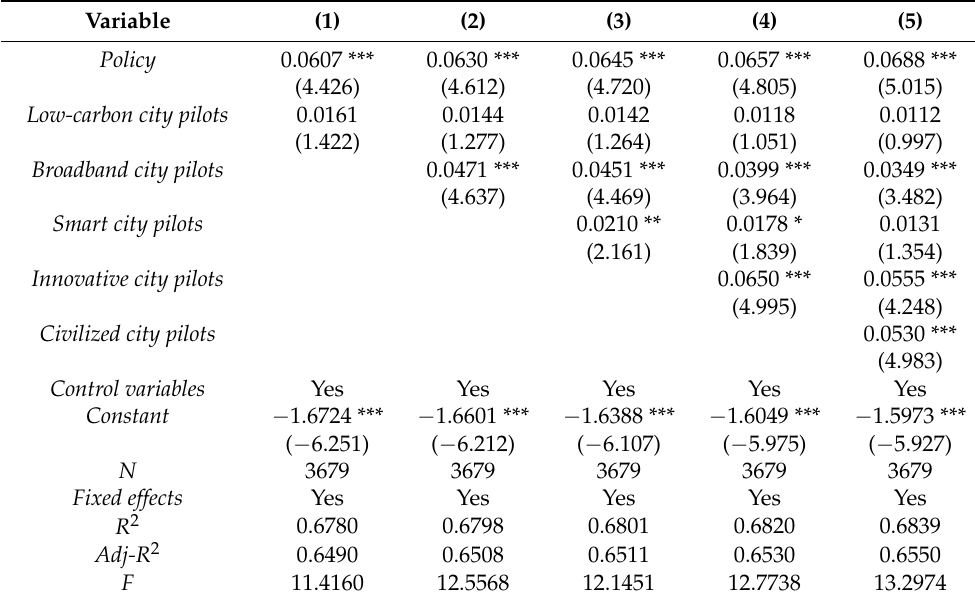
Table 3. Exclusion of other policy